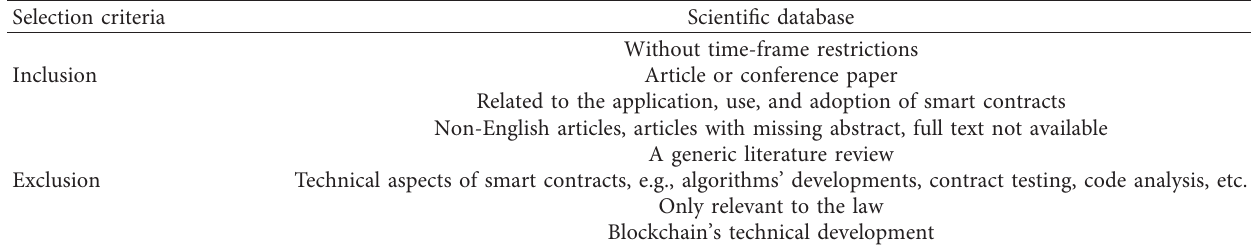
Table 1: Inclusion and exclusion criteria.